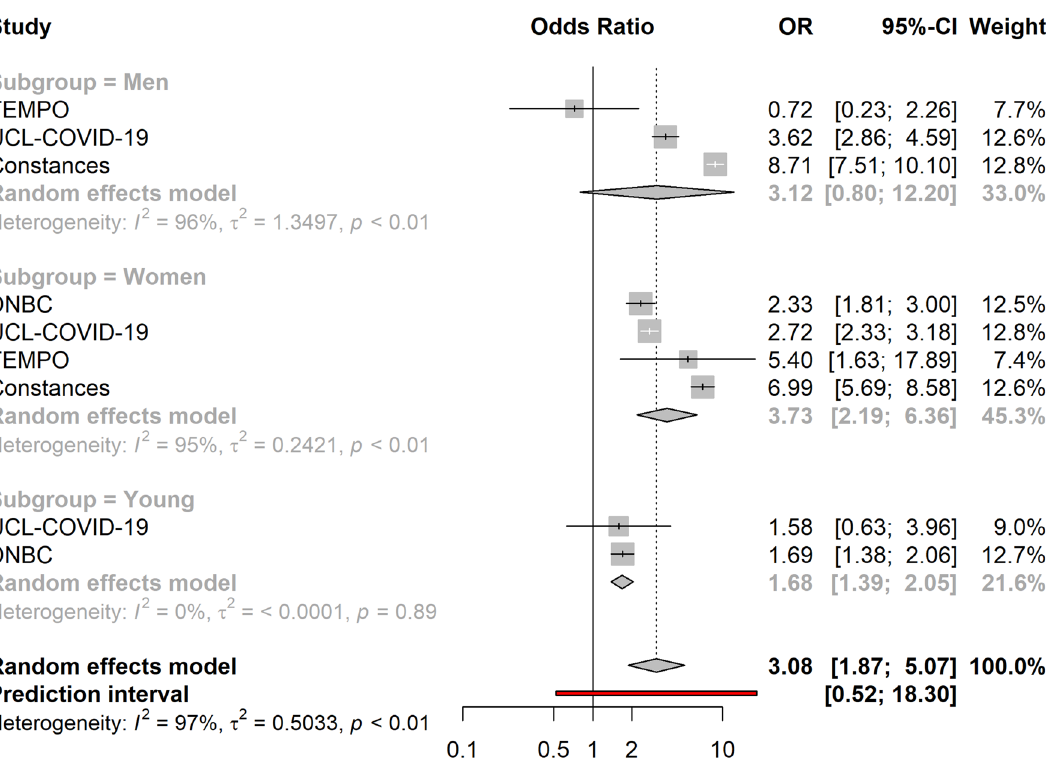
Figure 4. Association between living alone (vs. living with others) and high levels of loneliness (N = 69,136). The cohort-specific estimates and 95% confidence intervals were obtained using binary logistic regression models. Age, educational attainment, gender, previously diagnosed chronic disease status and presence of previously diagnosed mental illness were used a covariates. In addition, the models included mutual adjustment for the other housing exposures. 95% CI 95% confidence interval, OR odds